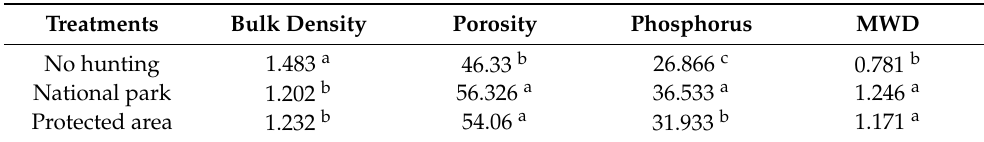
Table 3. Comparison of means for the soil physical–chemical properties.